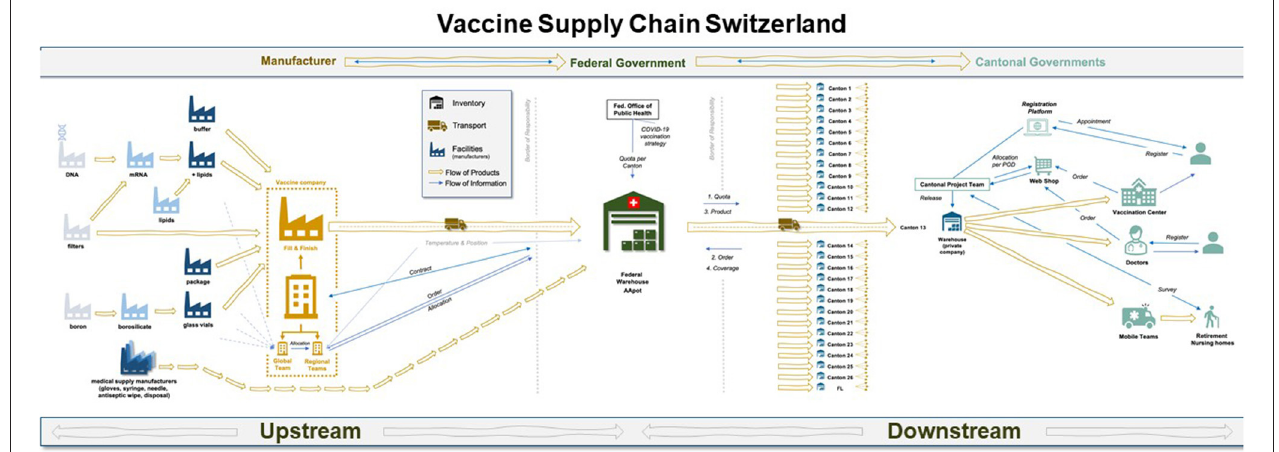
FIGURE 3 | Map of the end-to-end vaccine supply chain in Switzerland, as it was configured in 2021. The upstream section roughly begins with raw material suppliers and leads to the central warehouse managed by Swiss armed forces in a classified location. The downstream segment begins at the central warehouse for vaccine stockpiles to the arm of the patient. Source: authors.